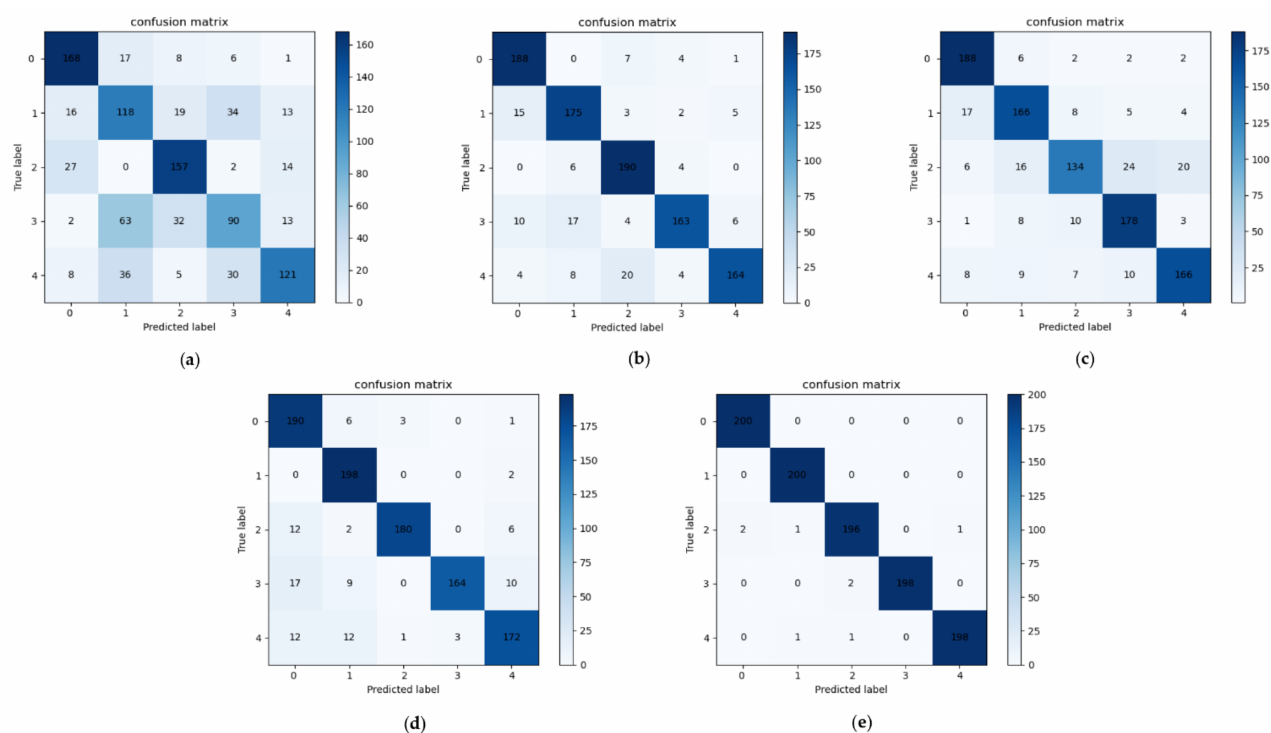
Figure 11. Confusion matrix for different methods: ( a ) SAE; ( b ) SDCAE; ( c ) EMDCNN; ( d ) EMDCNN– EMDCNN; ( e ) the proposed